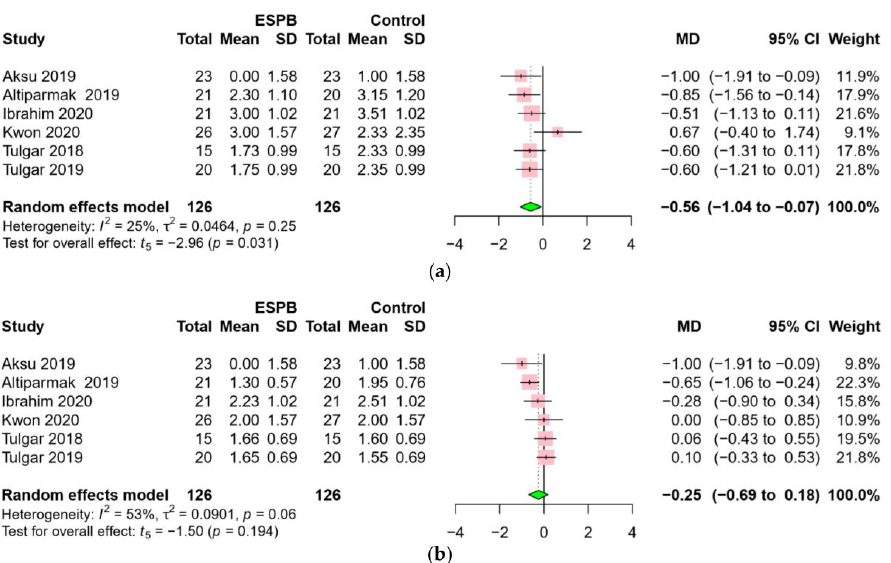
Figure 4. Forest plot for pain scores: ( a ) postoperative 12 h, ( b ) postoperative 24 h. ESPB provided lower pain scores until postoperative 12 h. Abbreviations: ESPB, erector spinae plane block; MD, mean difference; SD, standard deviation; CI, confidence interval.